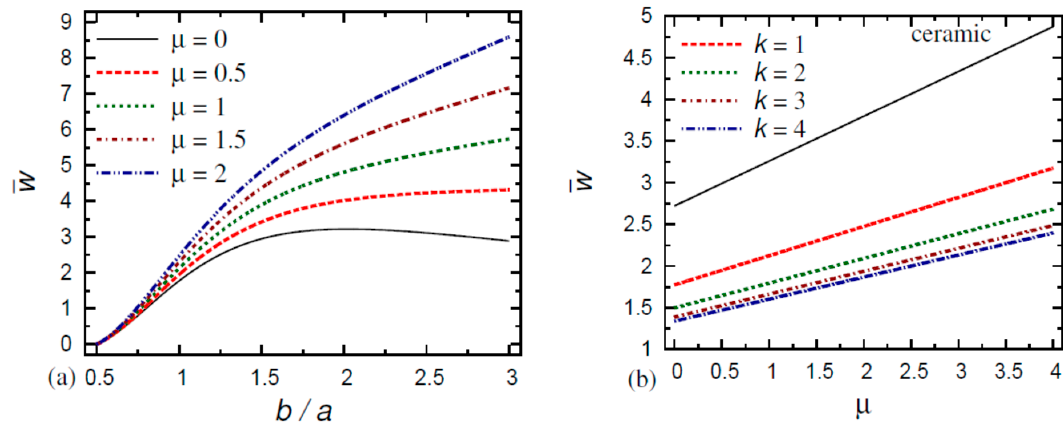
Figure 4. Variation in non-dimensional displacements w of FG nanoplates, a / h = 10, z / h = 0 ( a ) versus the aspect ratio b / a ( k = 1) and ( b ) versus the small length scale µ ( a = b